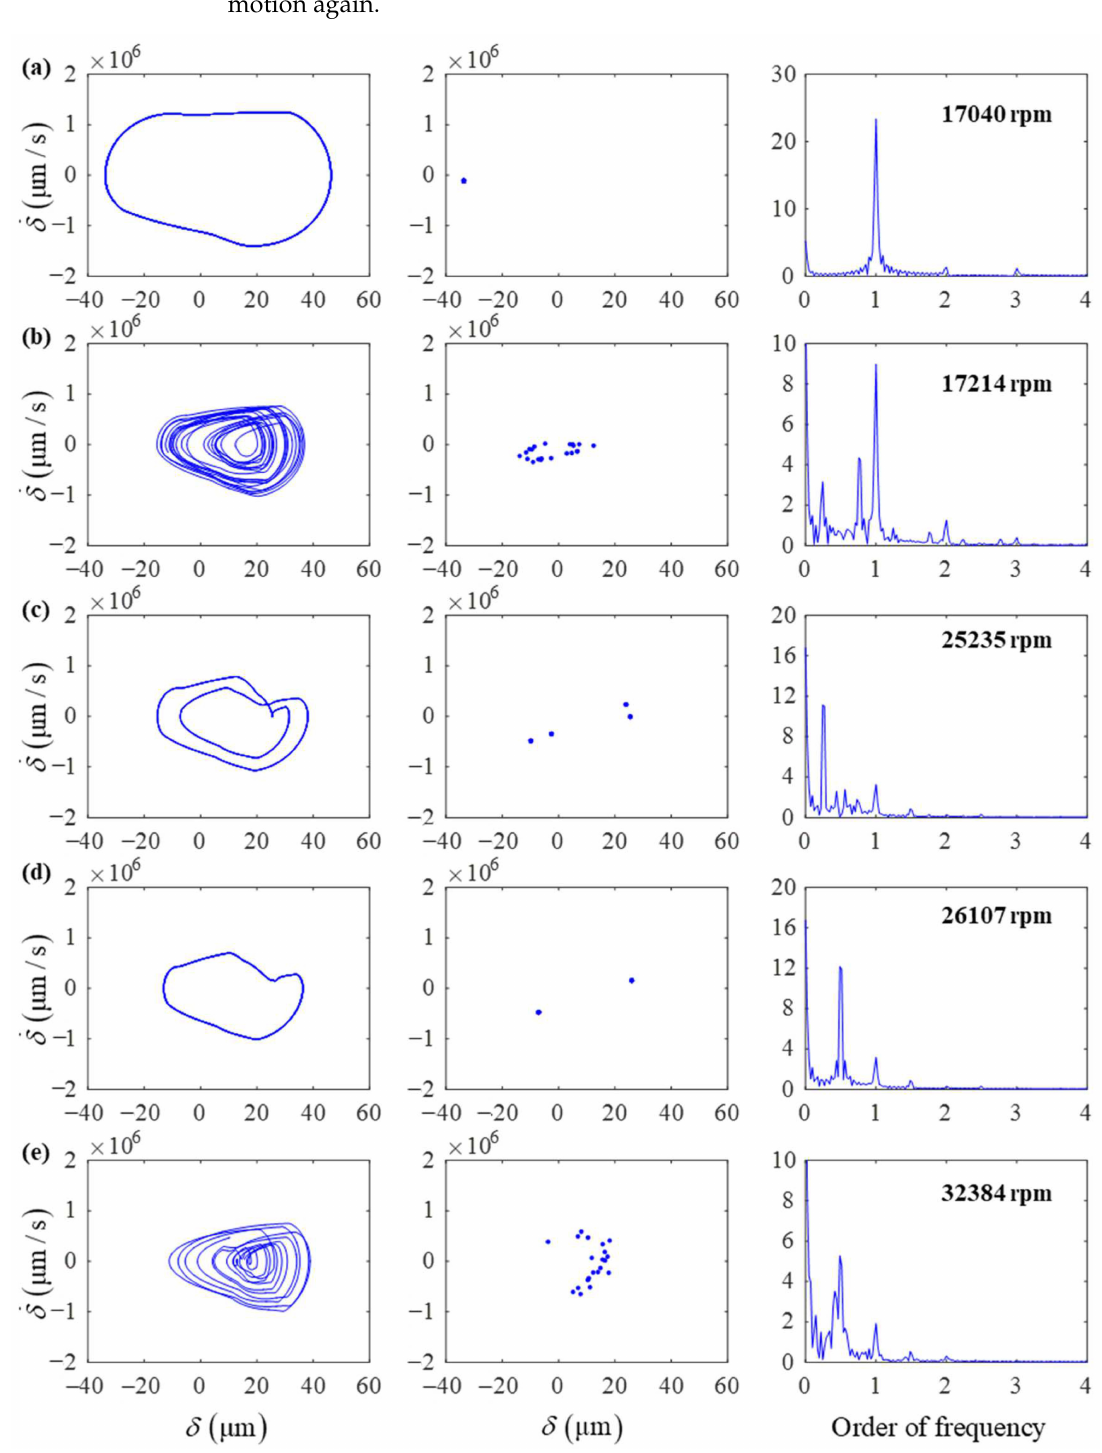
Figure 6. The orbit, Poincar é and FFT plots at different speeds ( a – e ). When the pinion speed increases to 22,445 rpm, the gear transmission system bifurcates to 4 T-periodic motion across a quasi-periodic motion in a short time. Four points are observed in the Poincar é plot at 25,235 rpm, and a quarter mesh frequency appears in